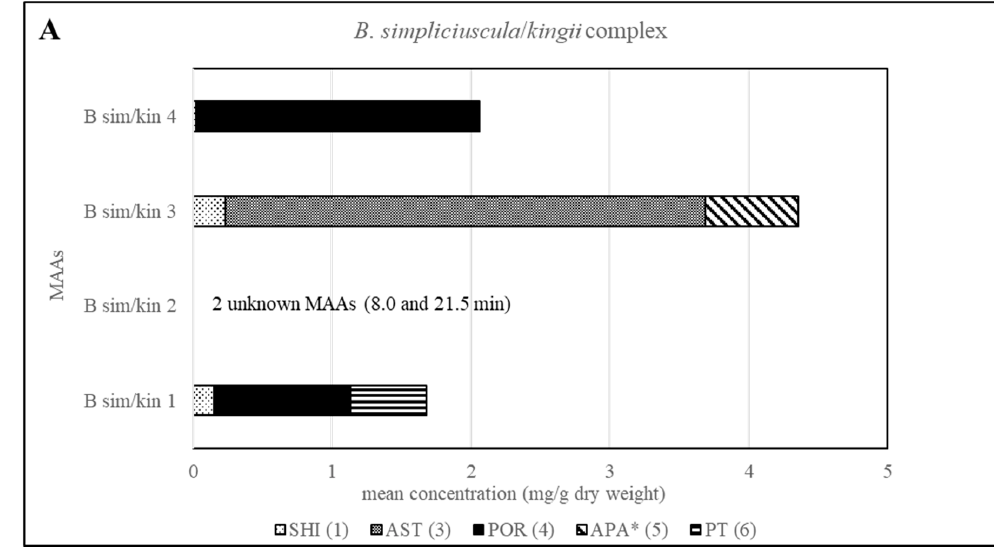
Figure 4. Overview of the content of MAAs expressed as mean value in mg per g of dry material for each lineage of the B. simpliciuscula/kingii complex. Assignment of the species: B sim, B . simpliciuscula ; B kin, B . kingii . * Tentative assignment because palythinol shows identical mass, retention time and UV spectra.